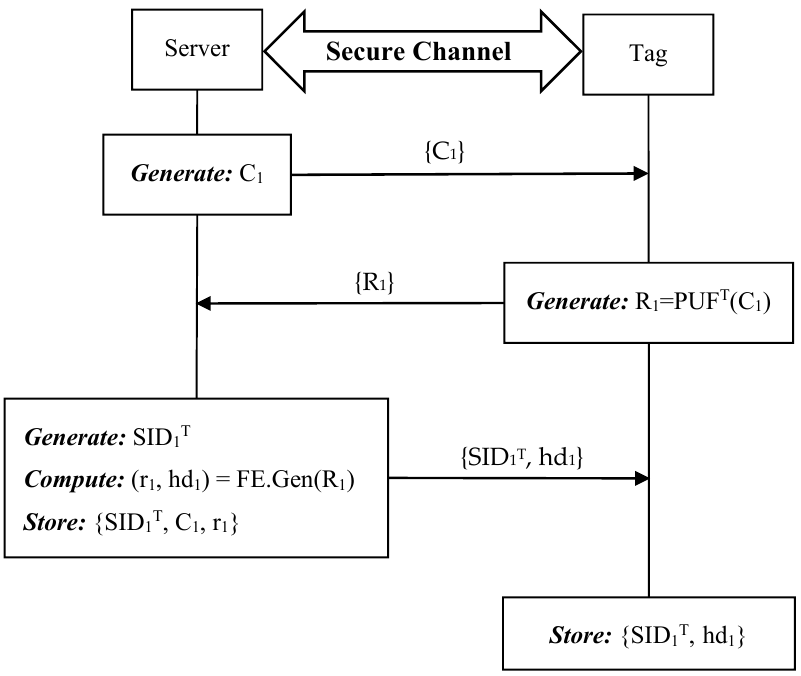
Figure 6. Setup phase of the proposed noisy PUF-based protocol.